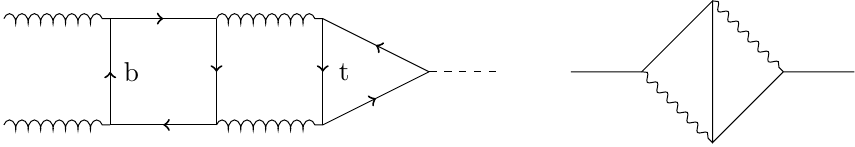
Figure 2 . A three loop contribution to Higgs production via gluon fusion with a bottom and a top quark running in the loops (left panel). The scalar kite Feynman graph with two massless and three propapagators of equal mass (right